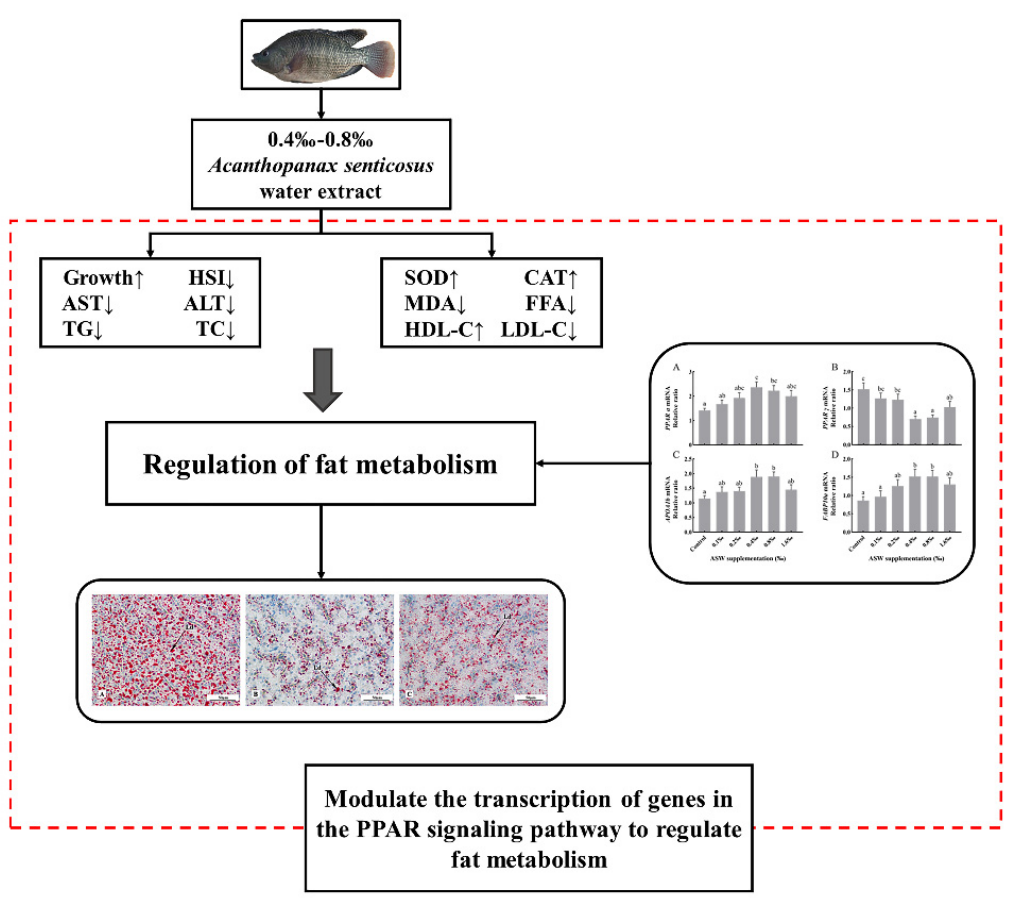
Figure 4. Pathways related to growth performance and fat metabolism in GIFT ( Oreochromis niloticus ) potentially affected by ASW supplementation in the diet.